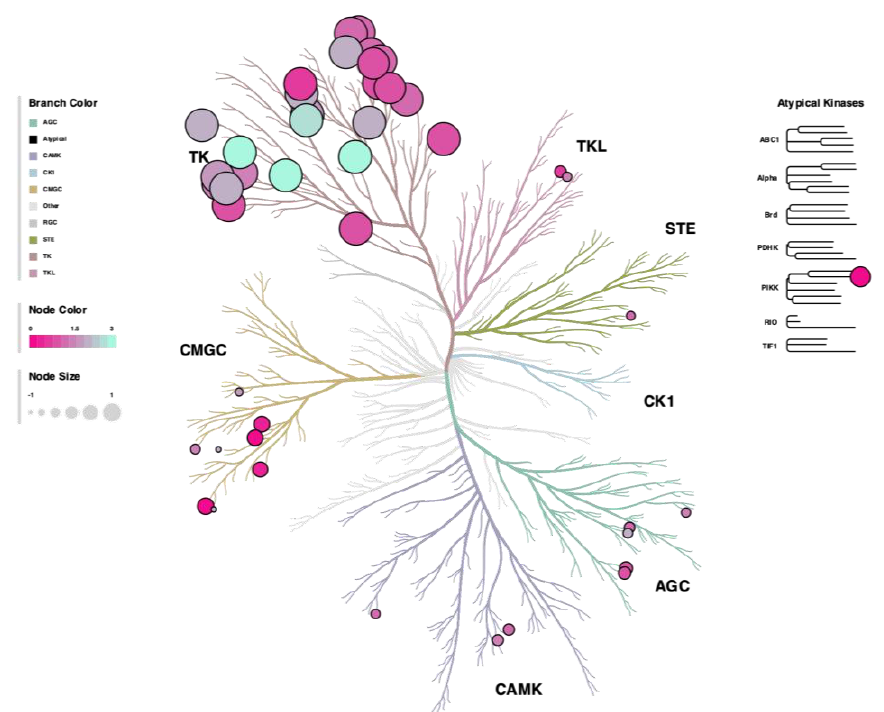
Figure 7. Kinase phylogeny tree of livers from GNUR-treated compared to CTRL-treated obese mice. Both STK and PTK results are included, where node size refers to the calculated mean final score and the node color refers to the median kinase statistic. Both measures are calculated by Bionavigator software (https://pamgene.com/technology/). The phylogeny tree was created using the CORAL software (https://github.com/dphansti/CORAL).